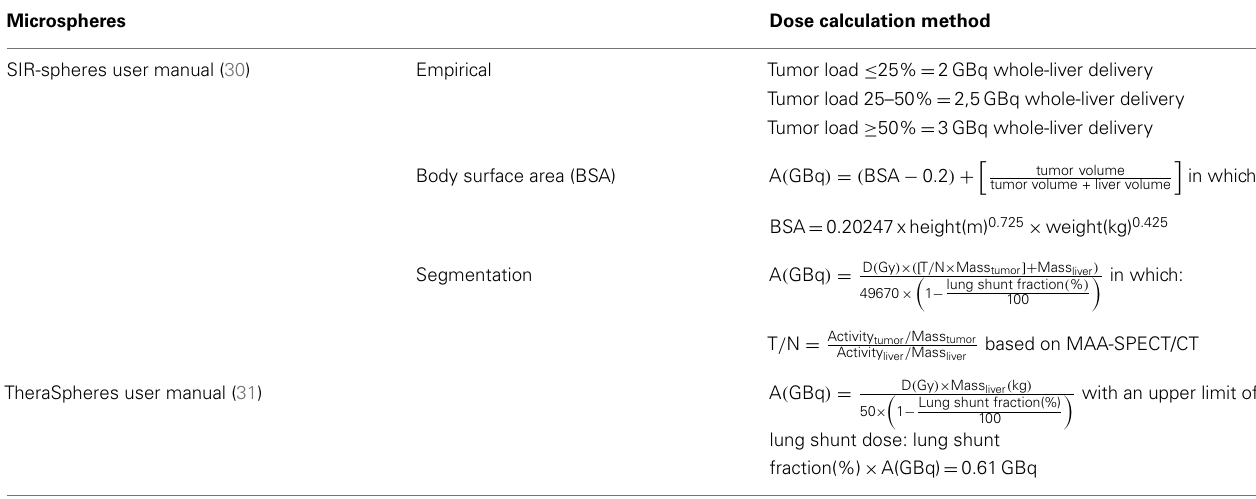
Table 1 | Dose calculation methods .